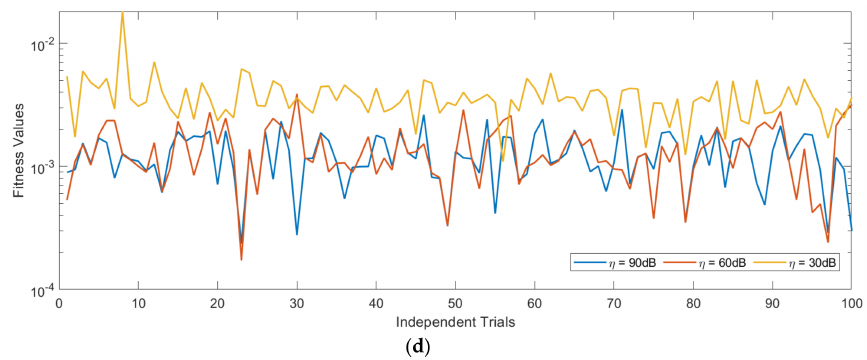
Figure 6. Results of fitness against independent trials ( a ) ε = 0.7 ( b ) ε = 0.8 ( c ) ε = 0.9 ( d ) ε = 1.0.